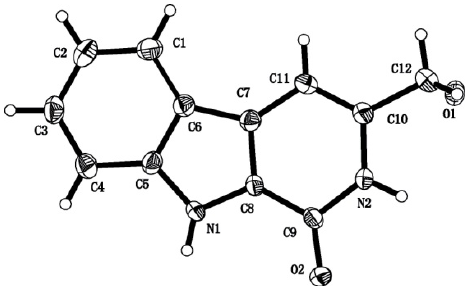
Figure 3. ORTEP drawing of the X-ray crystal structure of compound 6-2. Displacement ellipsoids were drawn at 50% probability